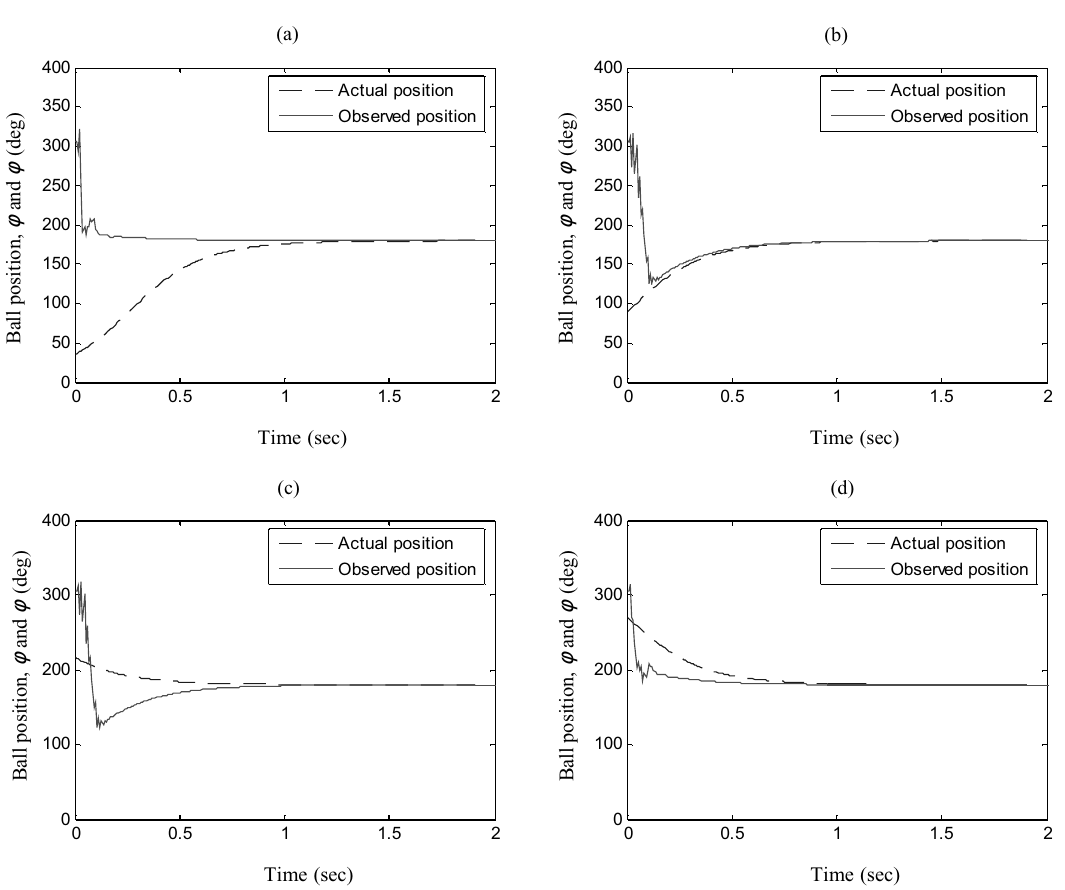
Fig. 9. Observed ball position based on the designed sliding-mode ball observer with l x = 460, k x = 4, a 1 = 1, a 2 = 1 and initial ball position at (a) 36 ◦ , (b) 90 ◦ , (c) 216 ◦ and (d) 270 ◦